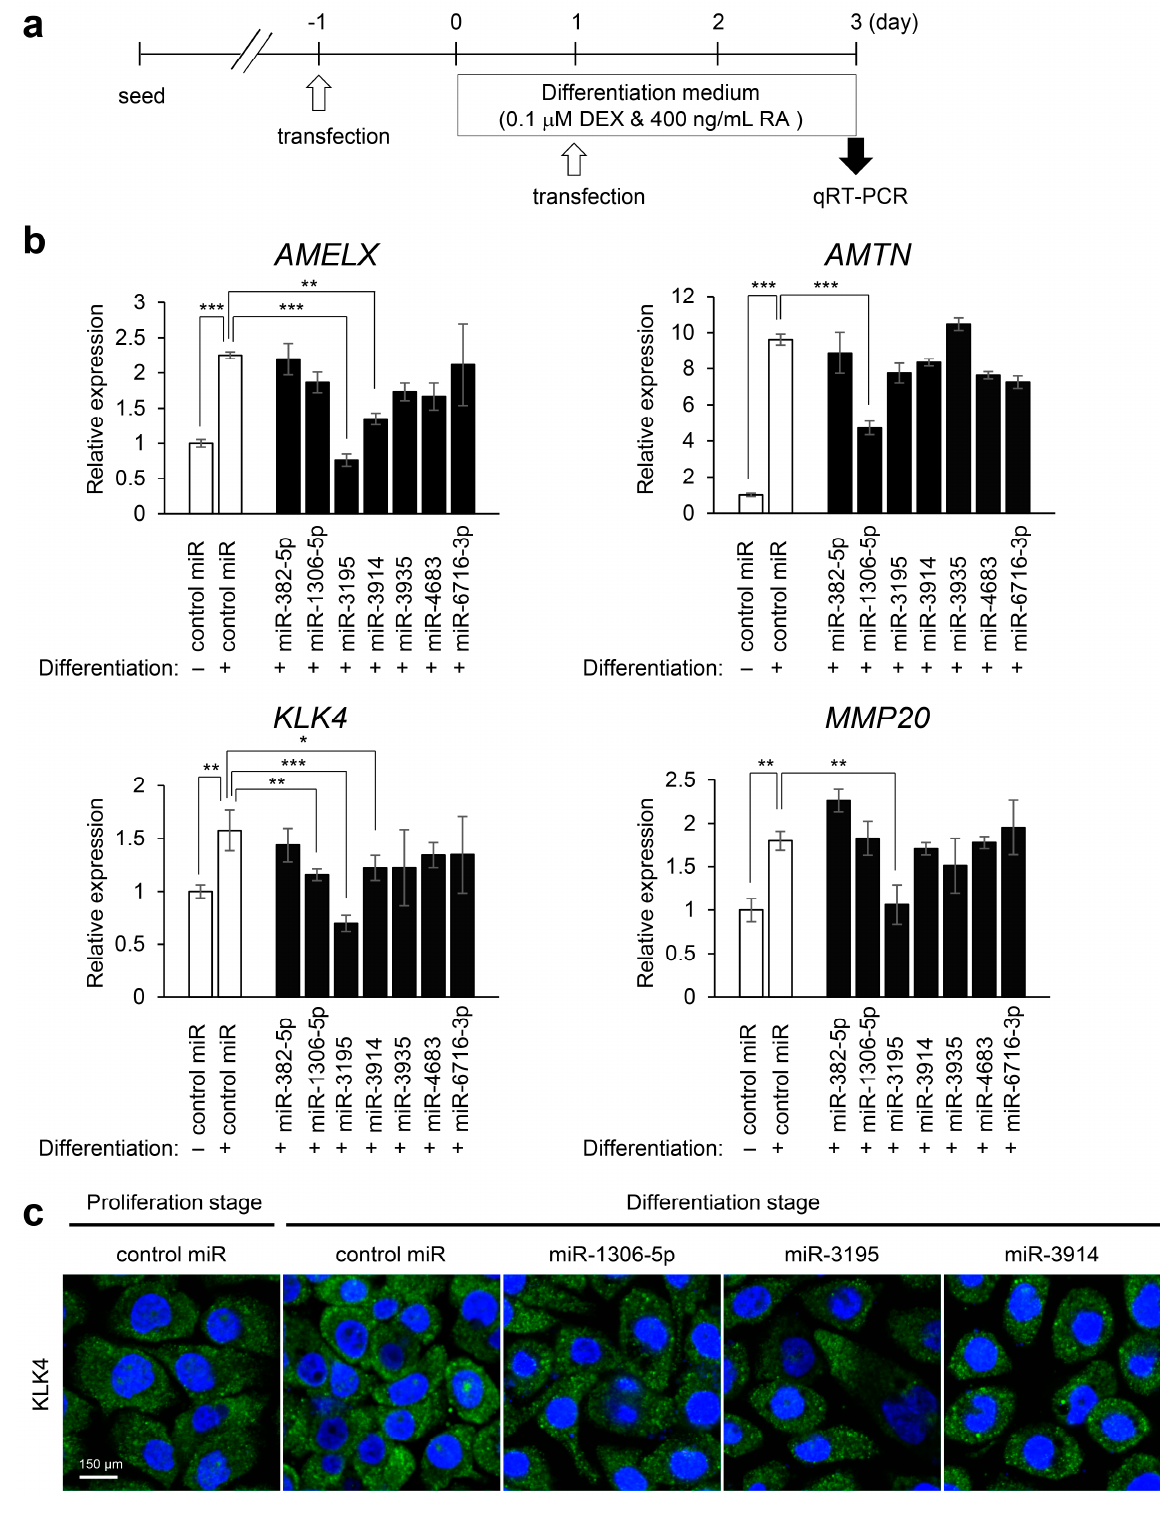
Figure 6. Effects of overexpression of candidate miRNAs on ameloblast differentiation. ( a ) Scheme of the experimental timeline. ( b ) Gene expression of AMELX, AMTN, KLK4, and MMP20 after treatment with a mimic of control or candidate miRNAs in AM-1 cells. * p < 0.05; ** p < 0.01, *** p < 0.001. ( c ) Immunocytochemistry analysis for KLK4 (green) in AM-1 cells under the indicated conditions. The nuclei were counterstained with 4’,6’-diamidino-2-phenylindole [DAPI (blue)]. Scale bar, 150 μ m.